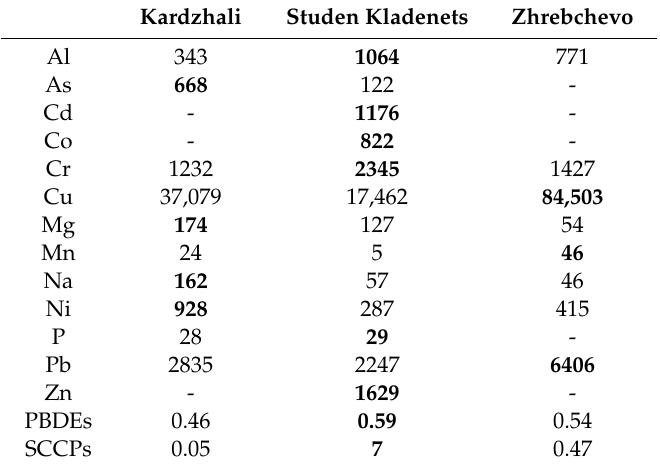
Table 3. Bioaccumulation factors (BAF) for 11 elements and organic contaminants in mussels from the studied stations. The analyzed elements (Ca, Fe, Hg, K), which were below the limit of detection (LOD) in all studied stations were excluded. Bold —highest BAF value for each element / substance. Kardzhali Studen